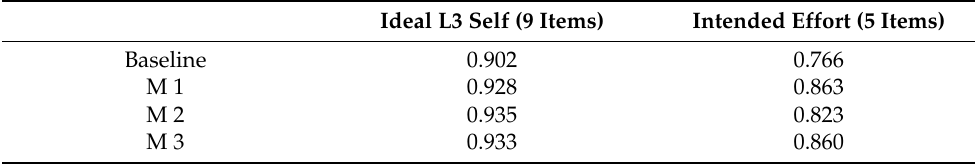
Table A1. Cronbach’s alpha for ideal L3 self and intended effort at different measurements.